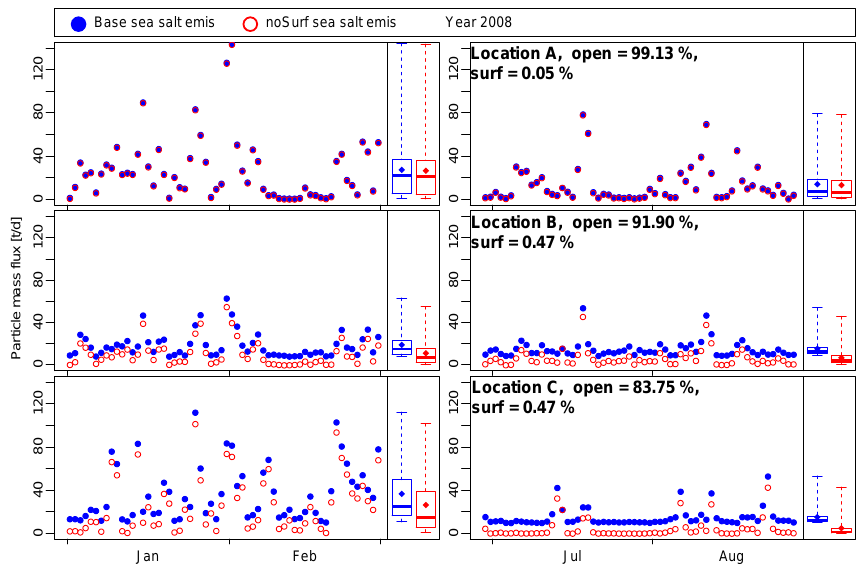
Figure 4. Daily averaged sea salt emission flux in t/d in three example coastal grid cells (one per row) in winter 2008 (left) and summer 2008 (right). The fraction of open ocean and surf zone is listed in the plots on the right. The remaining share is land. Location A is located on the Dutch coast, location B is on the German coast, and location C is on the Norwegian Atlantic